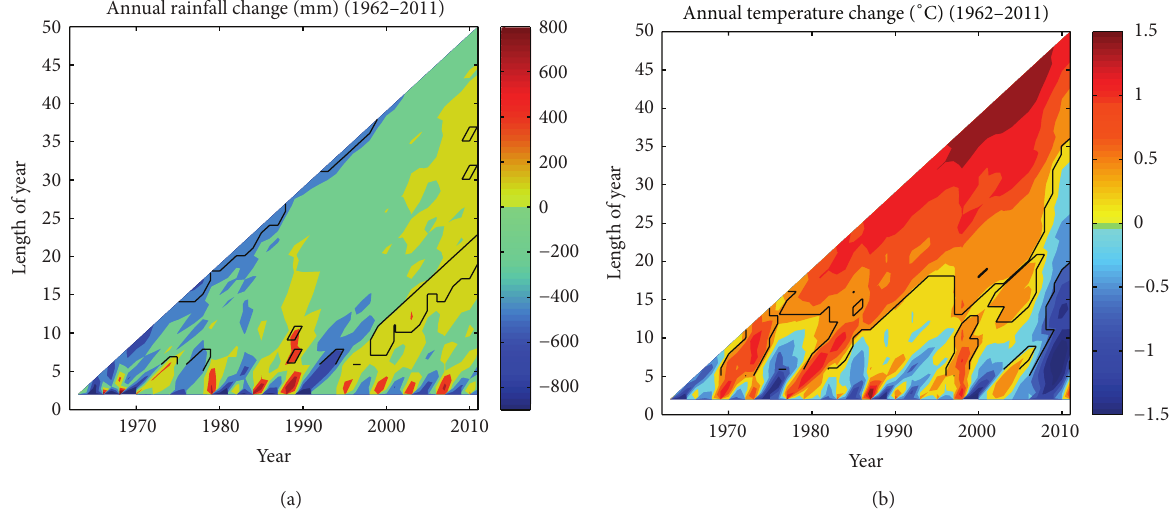
Figure 3: (a) Change of rainfall (in mm) and (b) air temperature ( ∘ C) from 1962 to 2011 as a function of length of time segment and ending year of calculation; the black contours provide the confidence ranking Students 𝑡